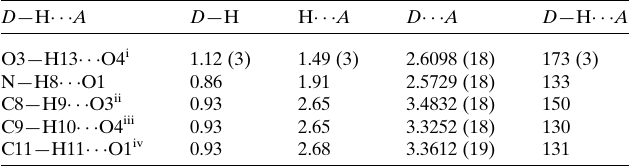
Table 6 Hydrogen-bond geometry (A˚ , (cid:3) ) for 3 .